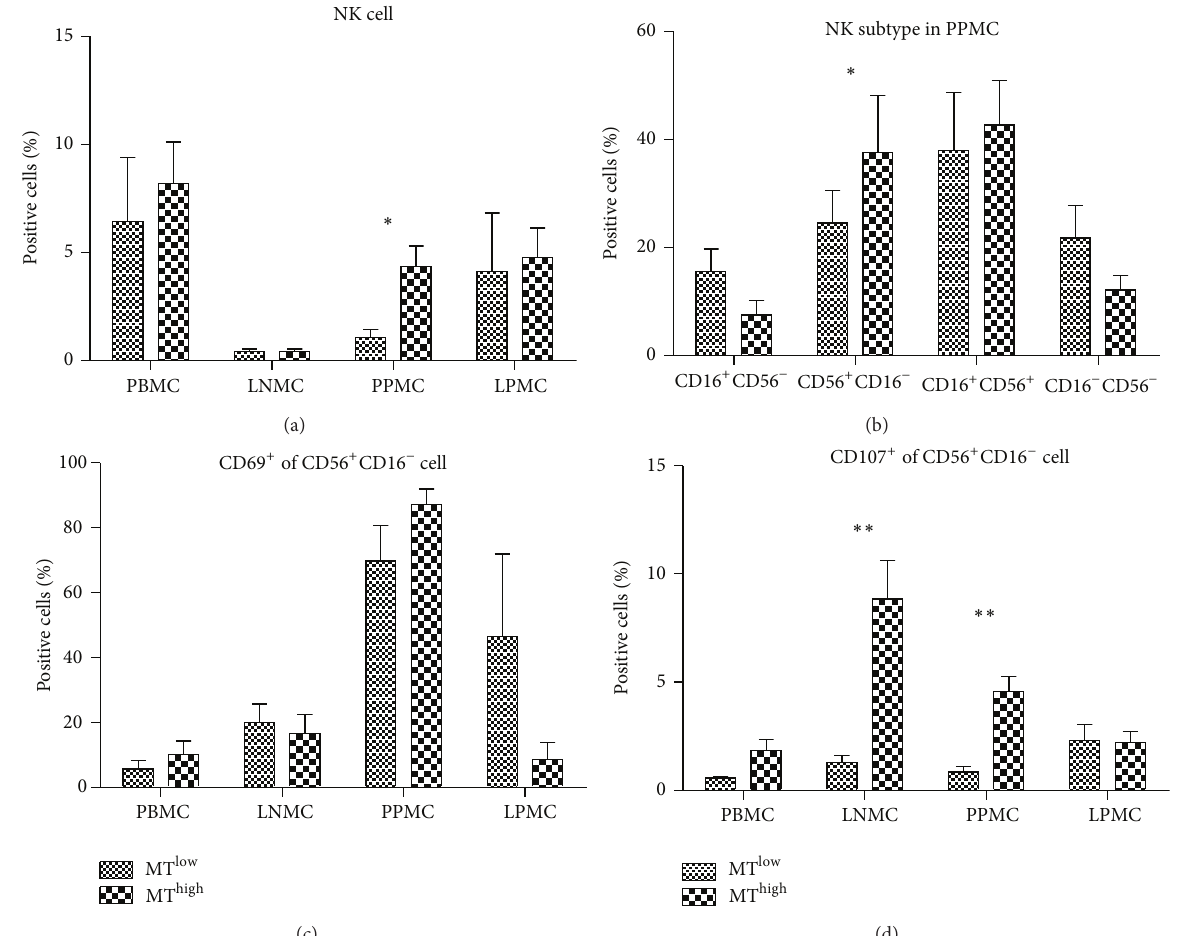
Figure 3: Numerical, phenotypical, and functional analyses of natural killer (NK) cells and the subtypes of different tissues from the microbial translocation ( MT ) high and MT low groups. (a) Distribution of macaque NK cell subsets in blood and tissues from the MT high and MT low groups. (b) NK cell subtype in Peyer’s patches mononuclear cells (PPMCs) of the MT high and MT low groups. (c) Expression of CD69 and (d) CD107a molecules on CD56 + NK cell subsets of the MT high and MT low groups. The column bar indicates the mean of the ratio of target cells (mononuclear cells in (a); NK cells in (b); CD56 + CD16 − NK cells in (c) and (d)). Error bars and individual standard deviations (SD) are shown. ∗ 𝑃 ≤ 0.05 and ∗∗ 𝑃 ≤ 0.01 as calculated by two-sided nonparametric Mann-Whitney 𝑈